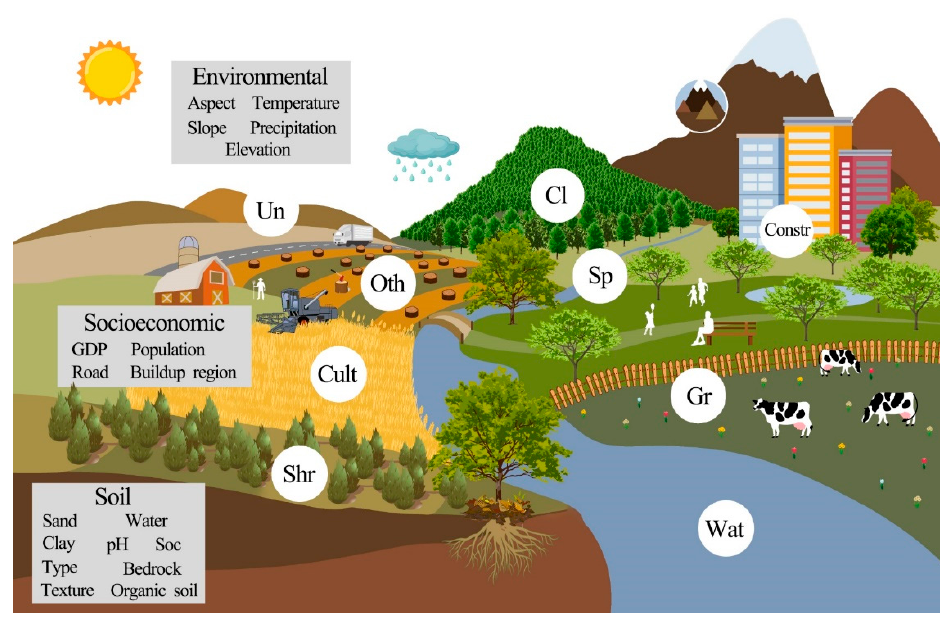
Figure 2. LUCC influence process.